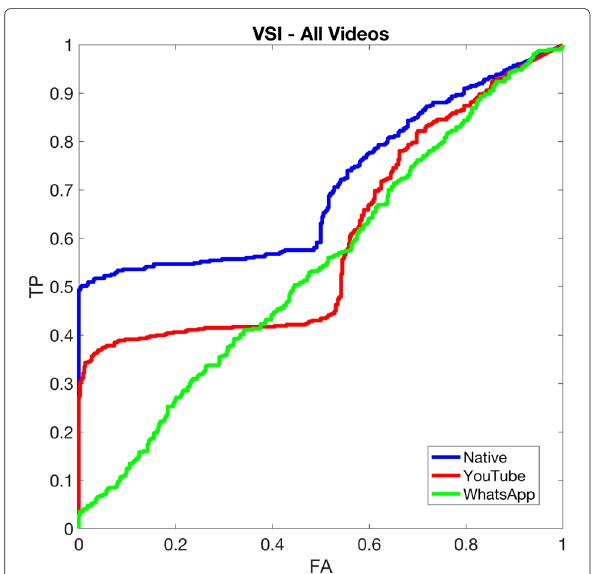
Fig. 5 (Best viewed in colors) The VSI performance on Native, YouTube, and WhatsApp videos (in blue, red and green respectively) considering all available